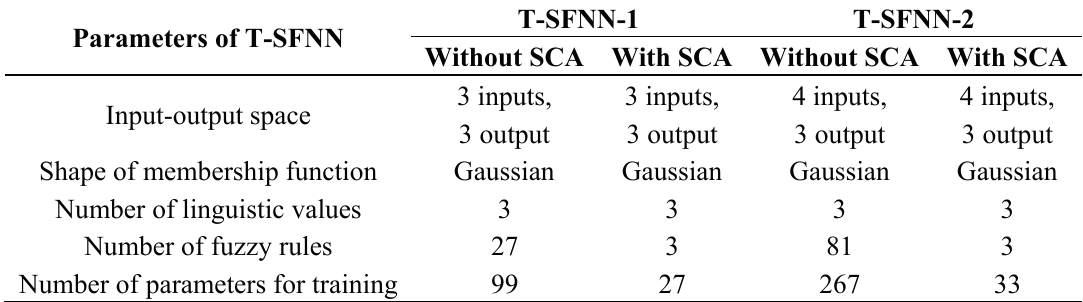
Table 5. Comparison of network structure of T-SFNN without and with SCA. Parameters of T-SFNN